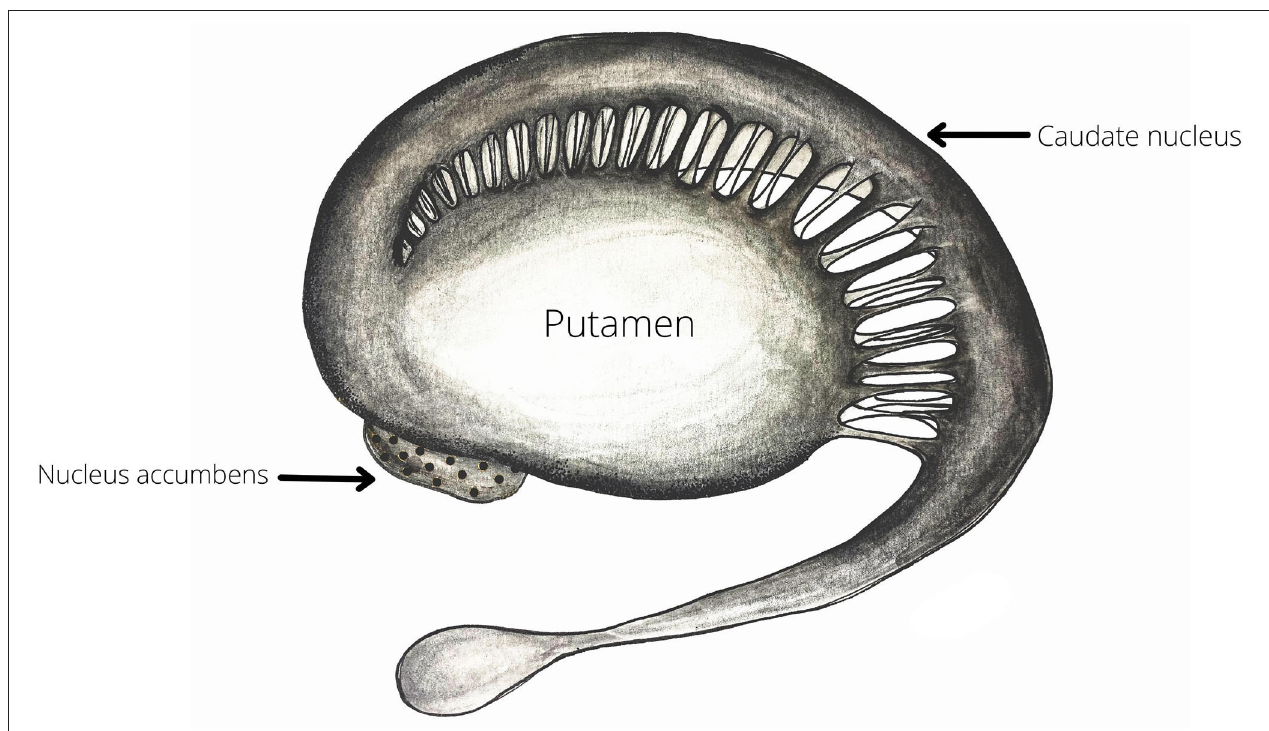
FIGURE 2 | The striatum—as demonstrated by Salimpoor and colleagues (72) both the ventral (Nucleus Accumbens) and the dorsal (Caudate nucleus and Putamen) deviasions of the structure are important for music-induces reward and expectation. Therefore, the striatum may be one of most robustly activated structures during by musical exercises ( Table 1